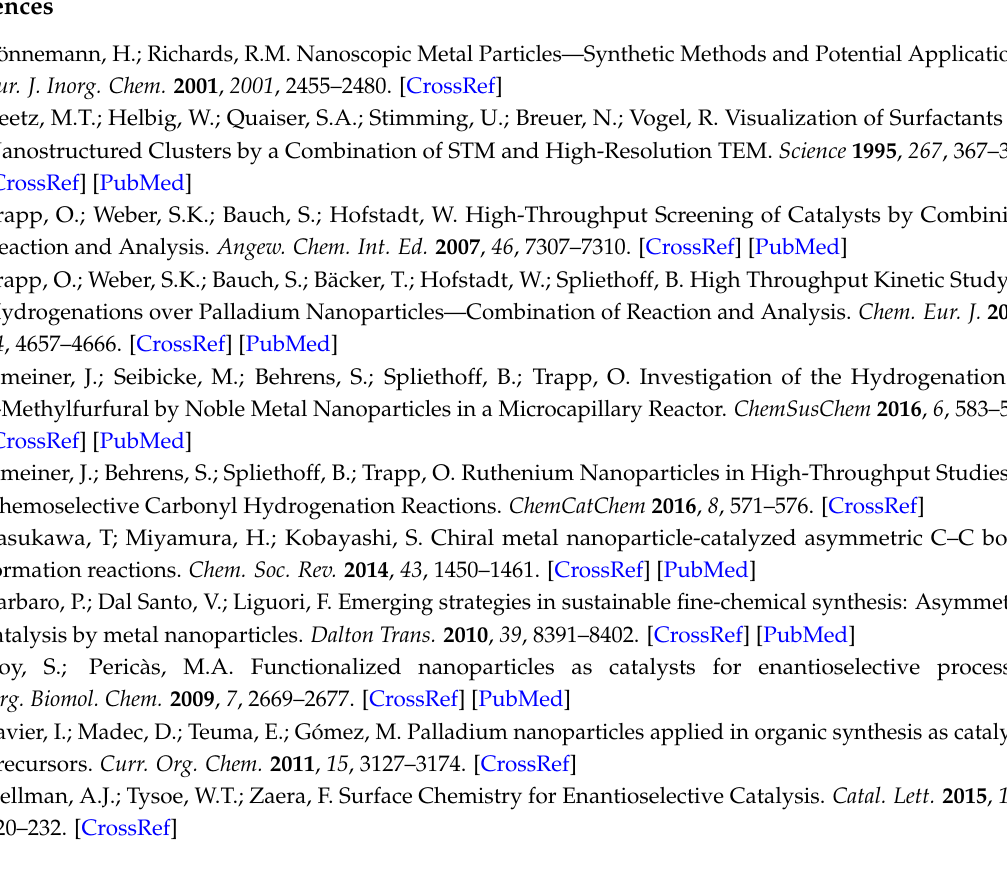
Figure S8: EDX (Energy Dispersive X-ray) analyses of PdL1, RuL1 and RuL2 , Figure S9: TEM images of PdL2 Figure S10: Mass spectrometry analyses of an organic phase of PdL1 treated with H 2 O 2 (aq) and extracted with CH 2 Cl 2 (FAB and DCI/NH 3 analyses), Figure S11: Mass spectrometry analyses of an organic phase of PdL2 treated with H 2 O 2 (aq) and extracted with CH 2 Cl 2 (FAB and DCI/NH 3 analyses), Figure S12: 31 P NMR spectra in CDCl 3 of PdNPs before and after addition of H 2 O 2 (aq), Table S1. Hydrogenation of styrene and 4-vinylpyridine catalysed by PdL and RuL ( L = L1 , L2